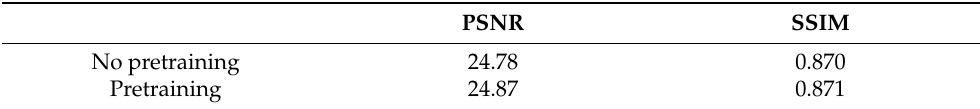
Table 3. Performance comparison of pretrained ViT discriminator on 256 × 256 image patches. The model was trained on Rain800 [21] and tested on Test100 [21].